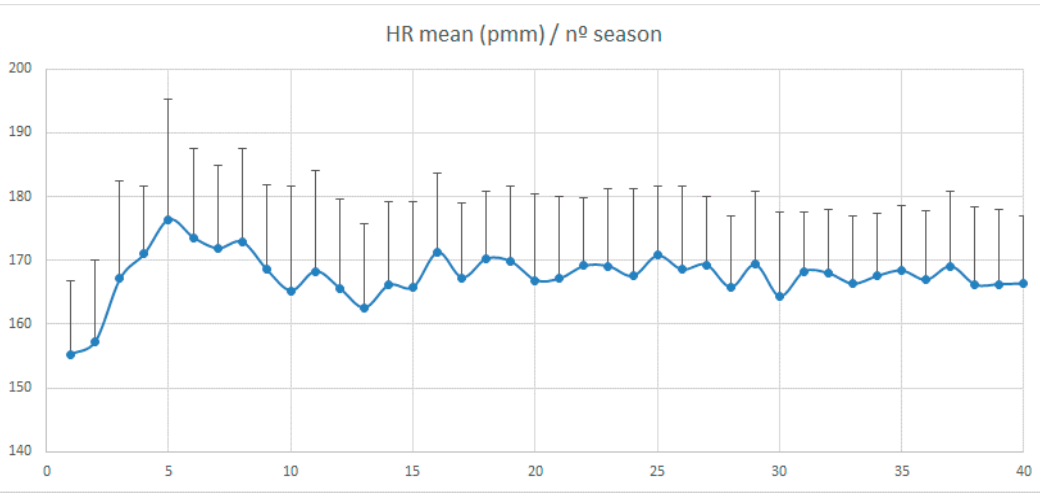
Figure 1. Mean heart rate per session.